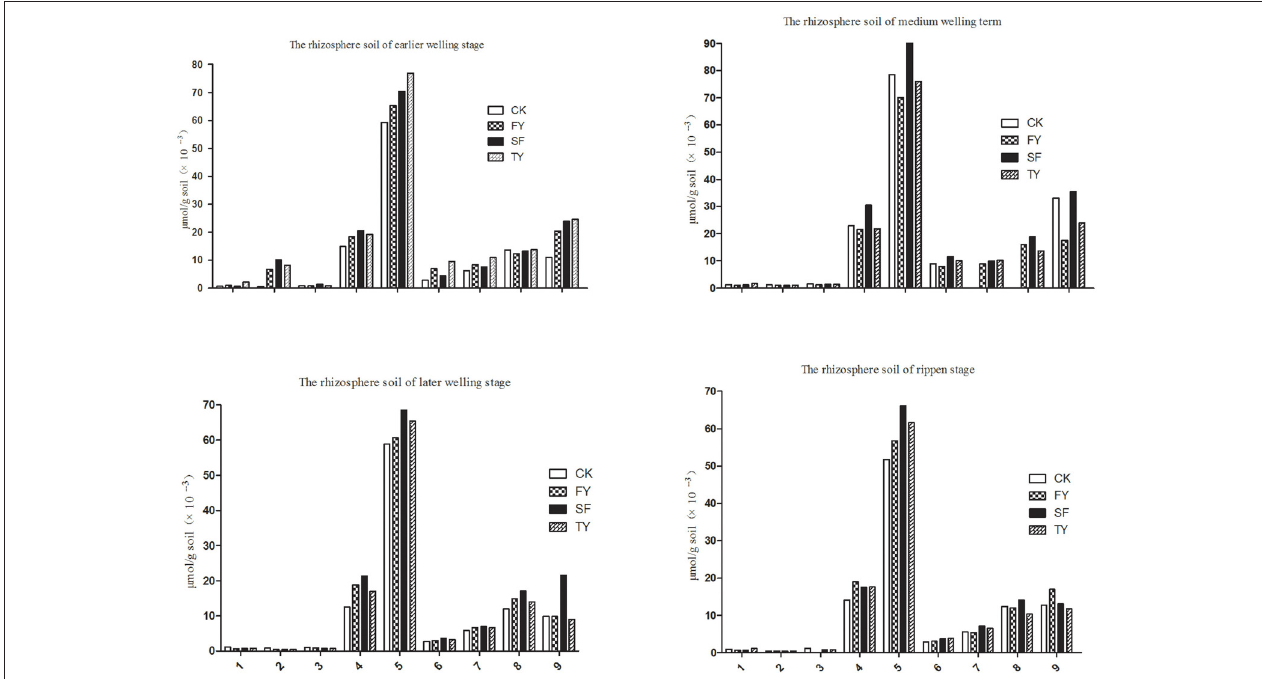
FIGURE 2 | Changes in the levels of phenolic compounds in the rhizosphere soil of R. pseudostellariae in a continuous cropping system sampled at different growth stages. 1, Represents gallic acid; 2, represents coumaric acid; 3, represents protocatechuic acid; 4, represents p-hydroxybenzoic acid; 5, represents vanillic acid; 6, represents syringic acid; 7, represents vanillin; 8, represents ferulic acid; 9, represents benzoic acid; FY, SY, TY: represent the first, second, and third cropping of R. pseudostellariae , respectively, grown in pots with the soil from the same plot.